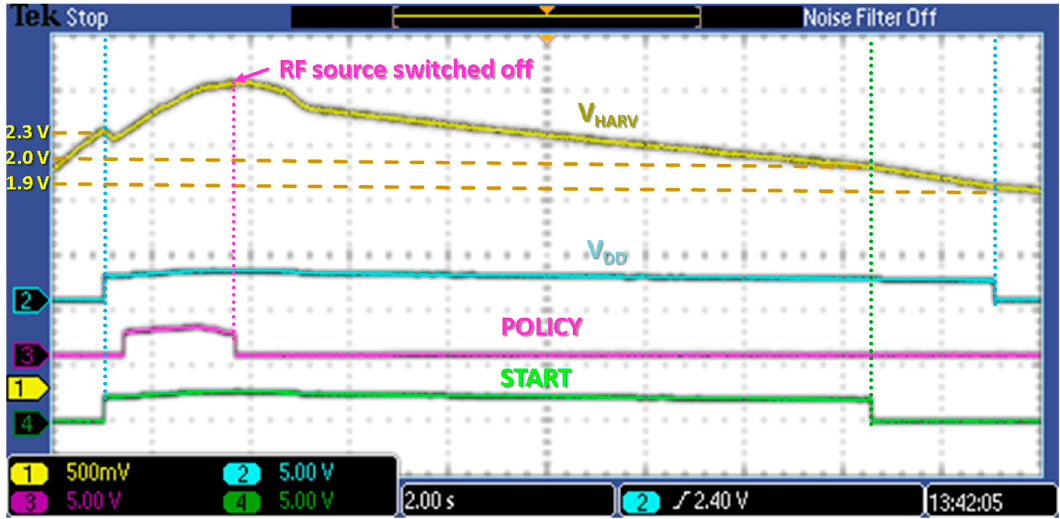
Figure 20. Power optimization circuits and policy detection waveforms.